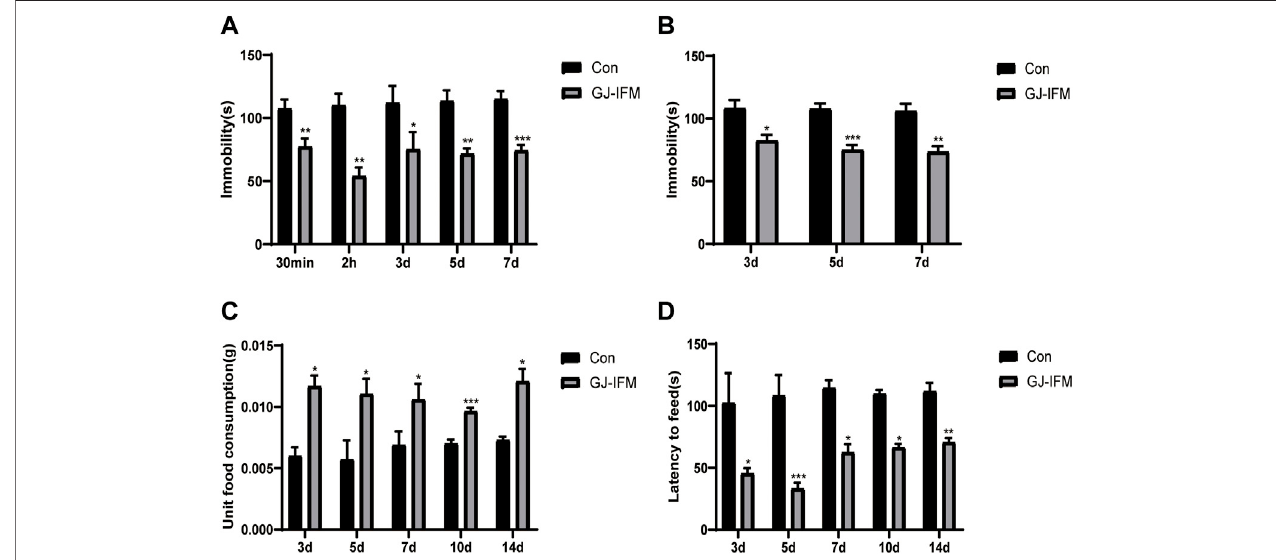
FIGURE 6 | The length of time for enduring rapid antidepressant effects of GJ-IFM on TST, FST, NSFT. (A) Tail suspension test after administration of GJ-IFM. t -test, * p < 0.05, ** p < 0.01, *** p < 0.001; control vs . GJ-IFM. (B) Forced swim test after administration of GJ-IFM. t -test, * p < 0.05, ** p < 0.01, *** p < 0.001; control vs . GJ-IFM. (C) Unitfoodconsumptionduring10mintestofnoveltysuppressed-feedingat1 dafteradministrationofthreedosesofGJ-IFM.* p < 0.05,*** p < 0.001;control vs. GJ-IFM. (D) Time oflatency to eat during 10 min test of novelty suppressed-feeding at 1 d after administration of three doses of GJ-IFM. t -test, * p < 0.05, ** p < 0.01, *** p < 0.001; control vs . GJ-IFM.